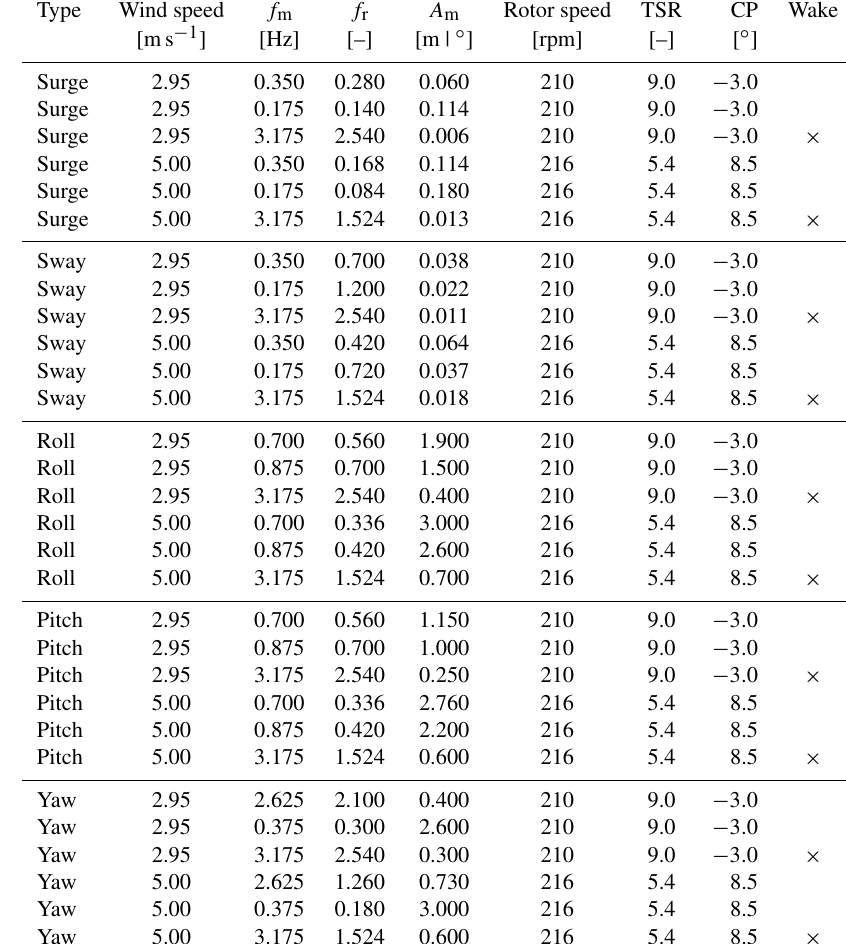
Table A1. Test matrix for cases with motion. f m is the frequency of motion, f r the rotor reduced frequency, A m the amplitude, TSR the tip-speed ratio, and CP the collective pitch. Wake measurements were carried out for load cases where an “X” is present in the “Wake”